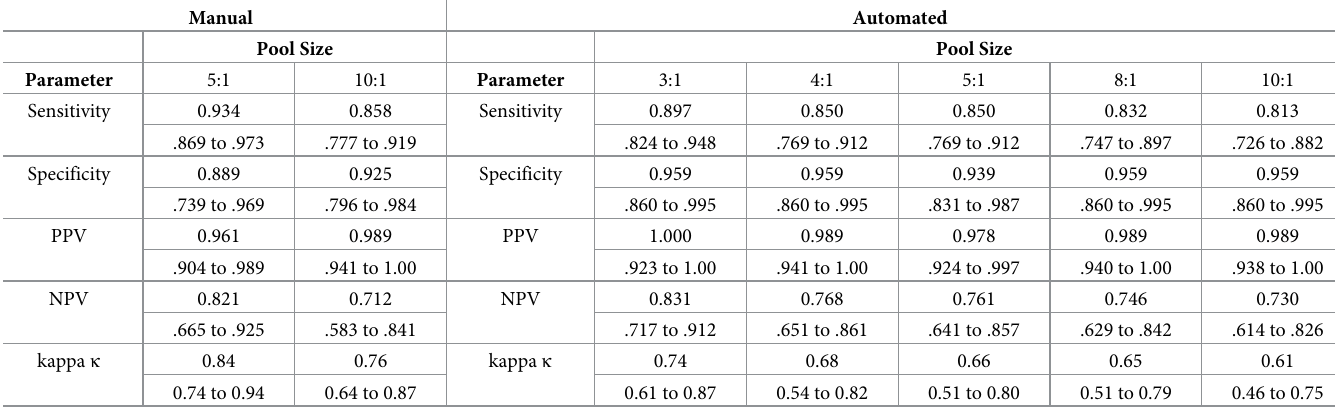
Table 6. Fusion 1 performance parameters.